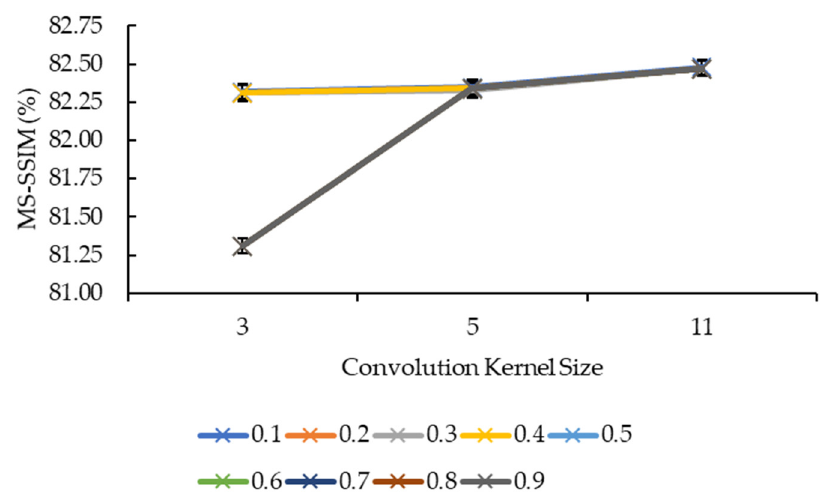
Figure 5. Graph of MS-SSIM against convolution kernel size.